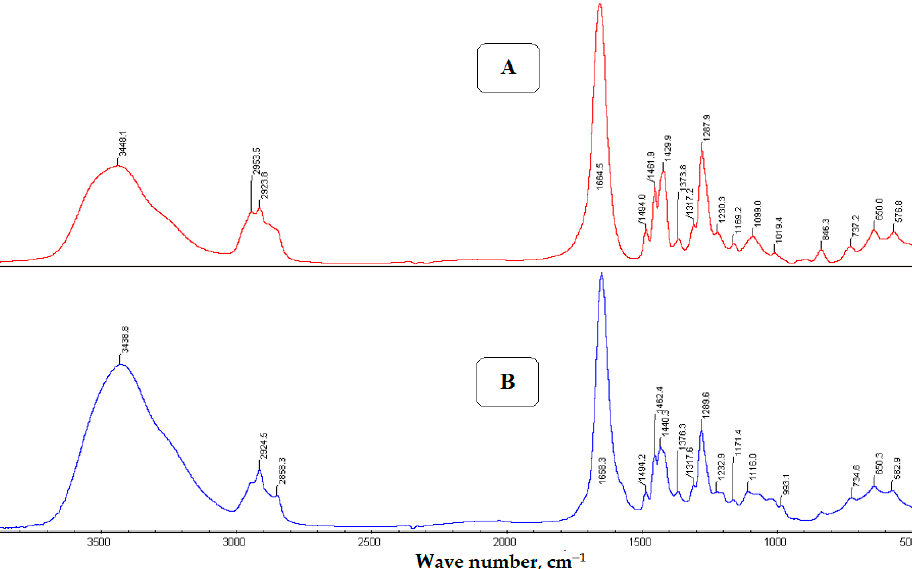
Figure 2. IR spectrum recorded in tablets of potassium bromide: ( A ) amphiphilic copolymer of N -vinyl-2-pyrrolidone and allyl glycyl ether; ( B ) copolymer of N -vinyl-2-pyrrolidone and allyl glycyl ether containing immobilized doxorubicin.